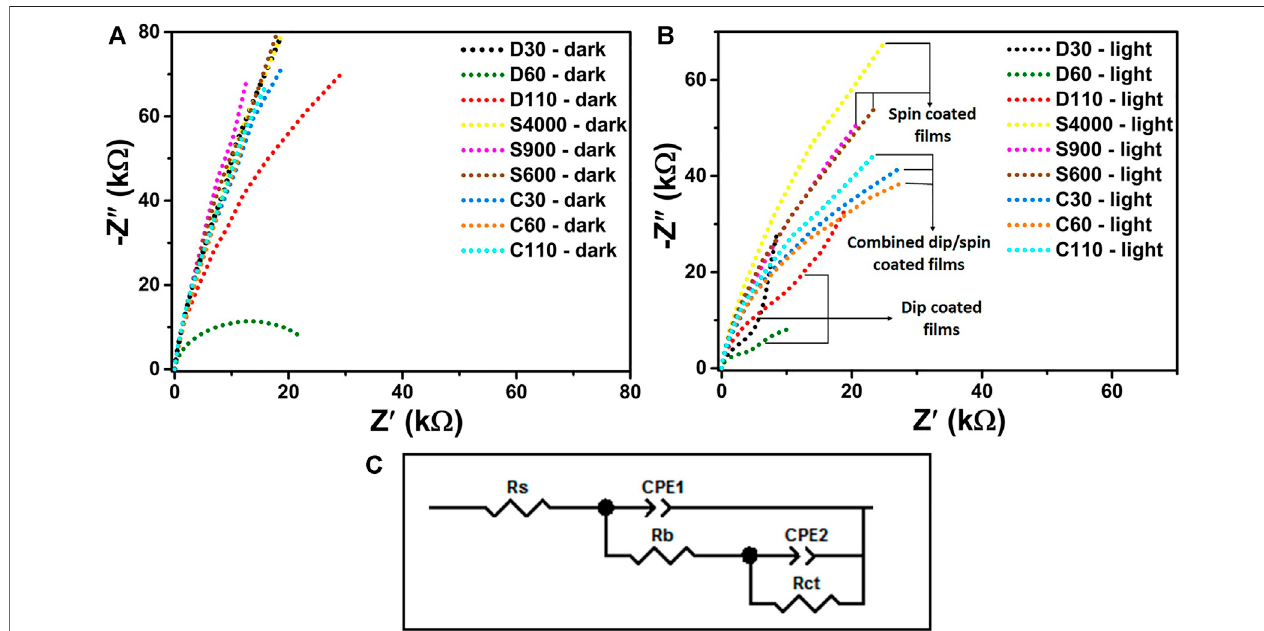
FIGURE7| EISanalysisof α -Fe 2 O 3 thin fi lmsformeasurementsperformedunder (A) darkand (B) illuminationconditionsrespectively,and (C) showstheequivalent circuit model employed in fi tting the raw EIS data.